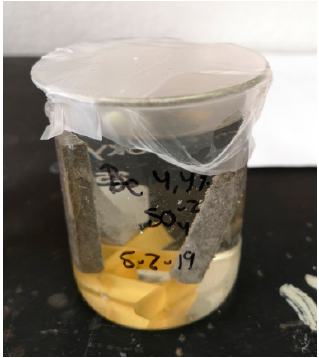
Figure 3. Koch–Steinegger exposure to sulfate attack.